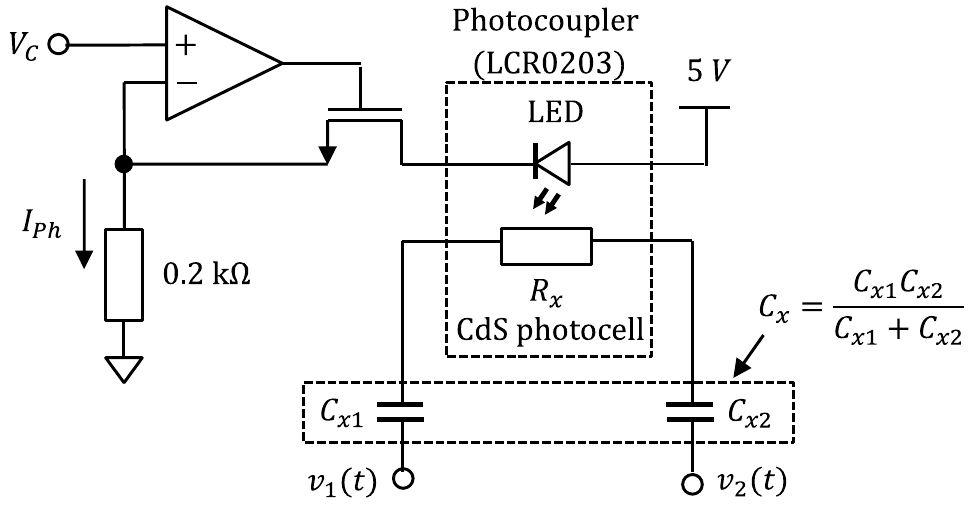
Figure 6. Constant current circuit for the LED current control of the photocoupler. The CdS photocell was used as a photosensitive resistor, which was connected in series with unknown capacitance C x to the nonsinusoidal oscillator shown in Figure 1.